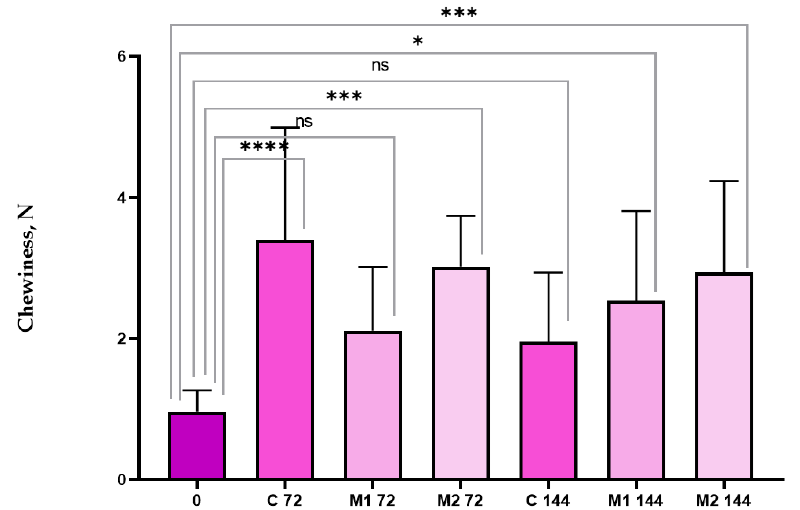
Figure 9. The chewiness of the sliced chicken sausage. ANOVA: ns—not significant; ****— p < 0.0001; ***— p < 0.001; *— p < 0.05.